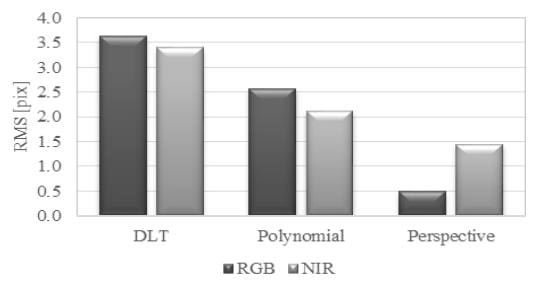
Figure 9. Summary of the mean error value for RGB and NIR image transformations